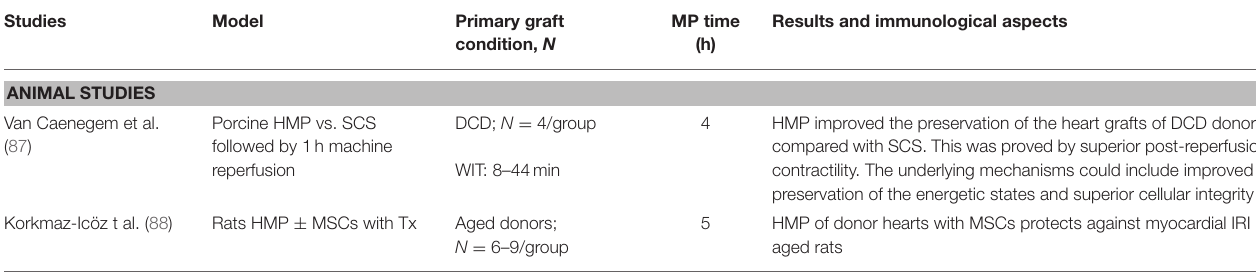
TABLE 4 | Experimental and clinical studies of machine perfusion of extended criteria donor heart grafts. Studies Results and immunological aspects